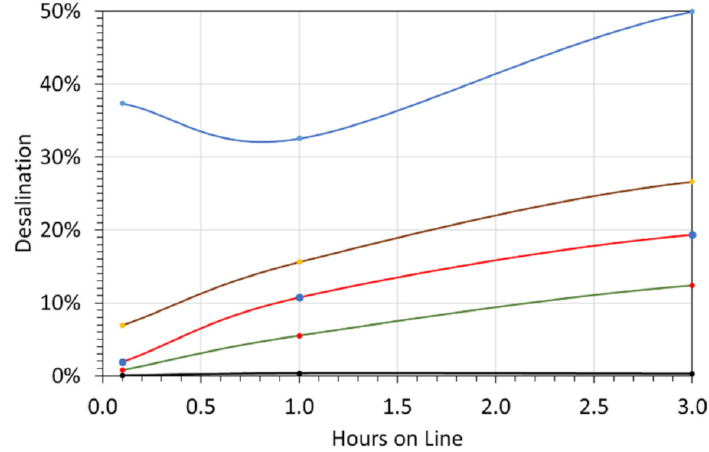
Figure 8. Outcome distribution associated with a single reactor train. Blue line = maximum desalina- tion; brown line = 25% probability of a higher desalination; red line = 50% probability of a higher desalination; green line = 75% probability of a higher desalination; black line = minimum desalination. Source: Appendix A, Figure A7.